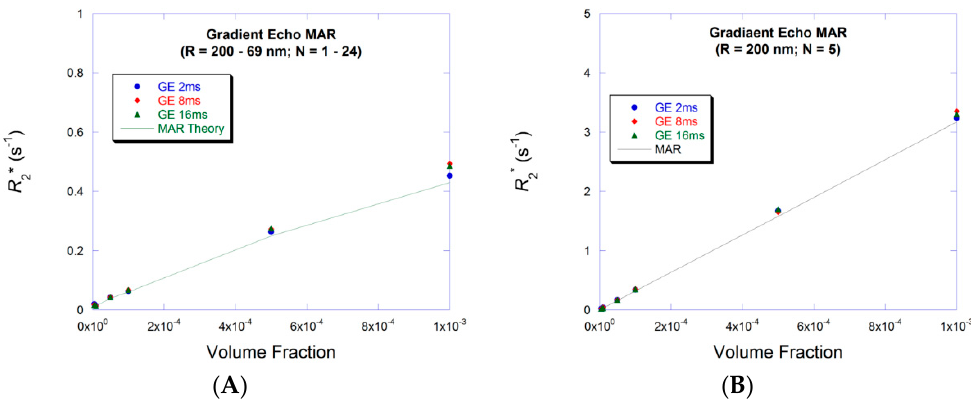
Figure 2. R 2 * values are plotted vs. particle volume fraction for particles within motional averaged (MAR). ( A ) The particle size is increased while the radius is decreased to achieve increasing volume fraction; ( B ) The particle size and radius are kept constant while the sample space is decreased to achieve increasing volume fraction. Relaxation is more efficient for few large particles ( B ) than for many small particles ( A ).